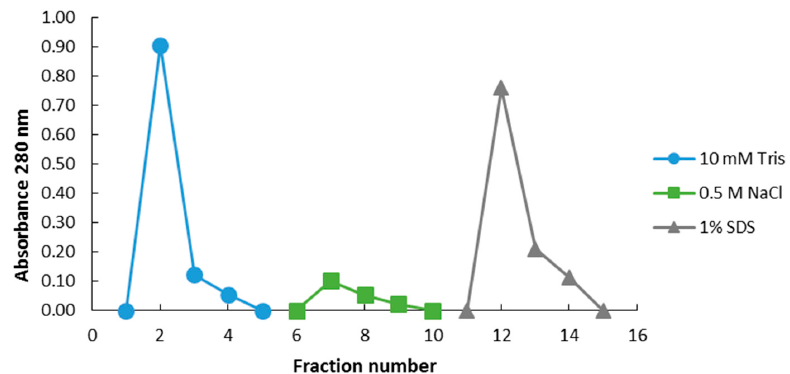
Figure 3. Representative elution profile of binding events between ergosterol-immobilized MagResyn™ magnetic microspheres and A. thaliana PM-associated proteins at 6 h following treatment. The blue curve represents the absorbance of the flow-through (unbound) fractions eluted with 10 mM Tris-HCl, pH 7.5. The green curve is the absorbance of the weakly bound proteins removed with 0.5 M NaCl, and the grey curve represents absorbance of proteins desorbed from the column with 1% SDS solution.